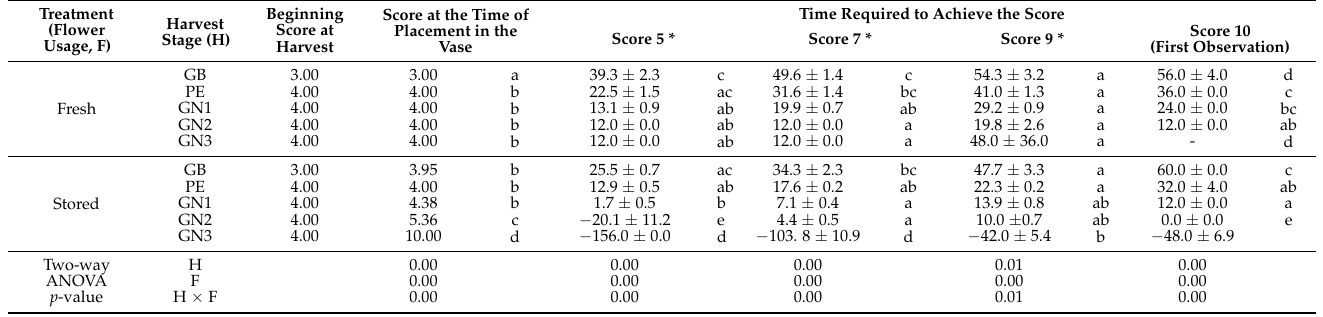
The different letters next to the mean and standard deviation represent the difference between the treatments at the p < 0.05 level. * Interpolated data (by linear interpolation). Table 4. Time to reach the selected values of ornamental value in the flower senescence phase.